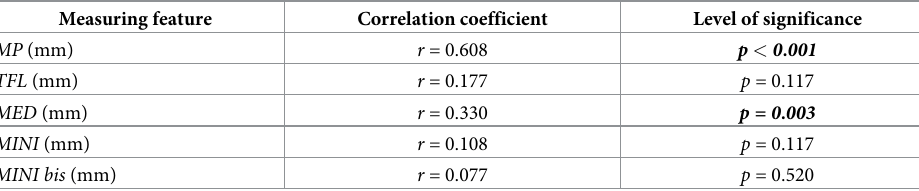
Table 4. The correlation coefficients of the analyzed parameters with the age of the fetus.